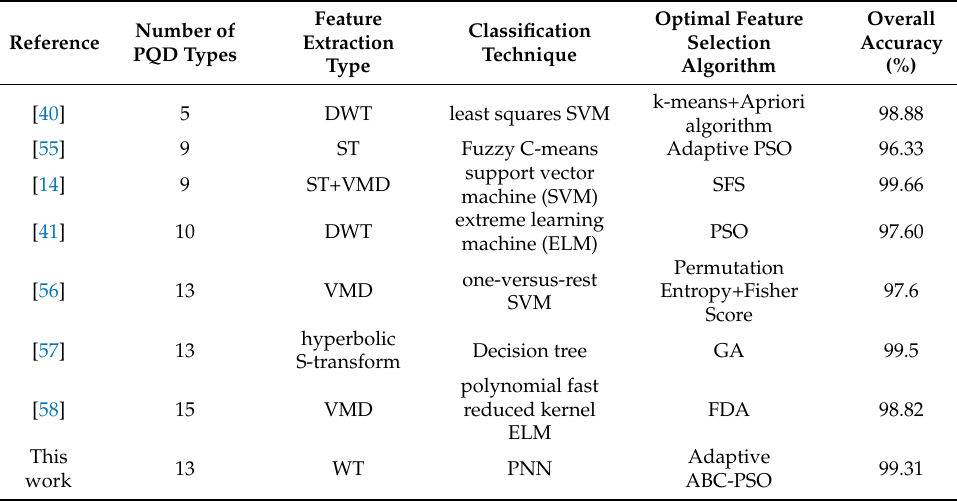
Table 10. A comparison of classification accuracy with previous